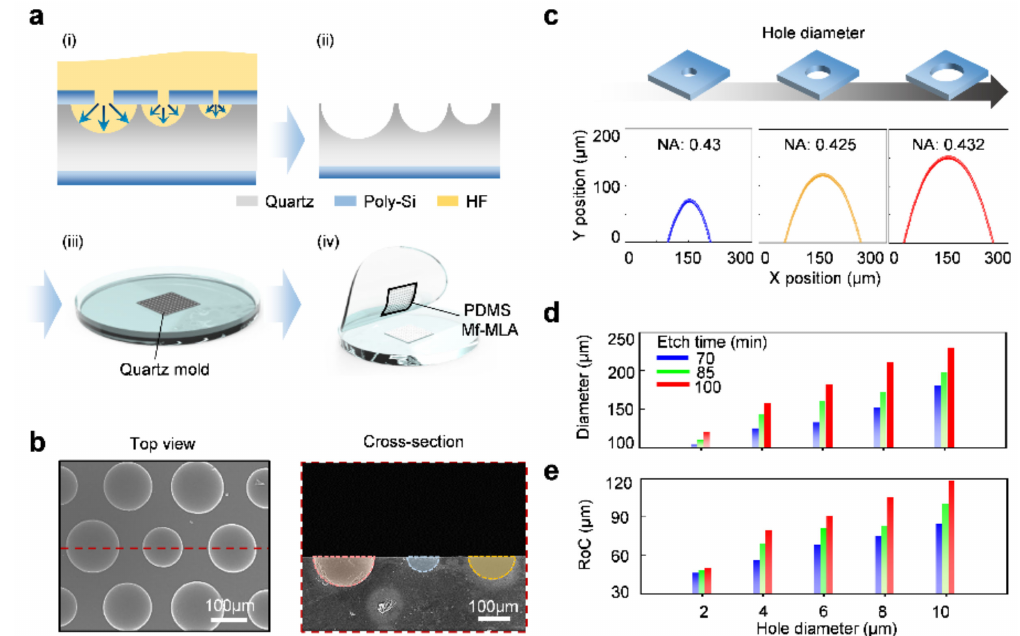
Figure 2. ( a ) Process schemes for Mf-MLA fabrication with three di ff erent radii of curvature (RoC). Diverse lens diameters of Mf-MLA are controlled by the via-hole size. ( b ) SEM image of the fabricated quartz master mold with di ff erent viewing angle, Top view; (left) and cross-sectional view (right). ( c ) The measured morphology profiles of replicated PDMS Mf-MLA with di ff erent via-hole diameters. ( d ) The diameter changes of each microlens according to the wet etch time. ( e ) The RoC change of each microlens according to the wet etch